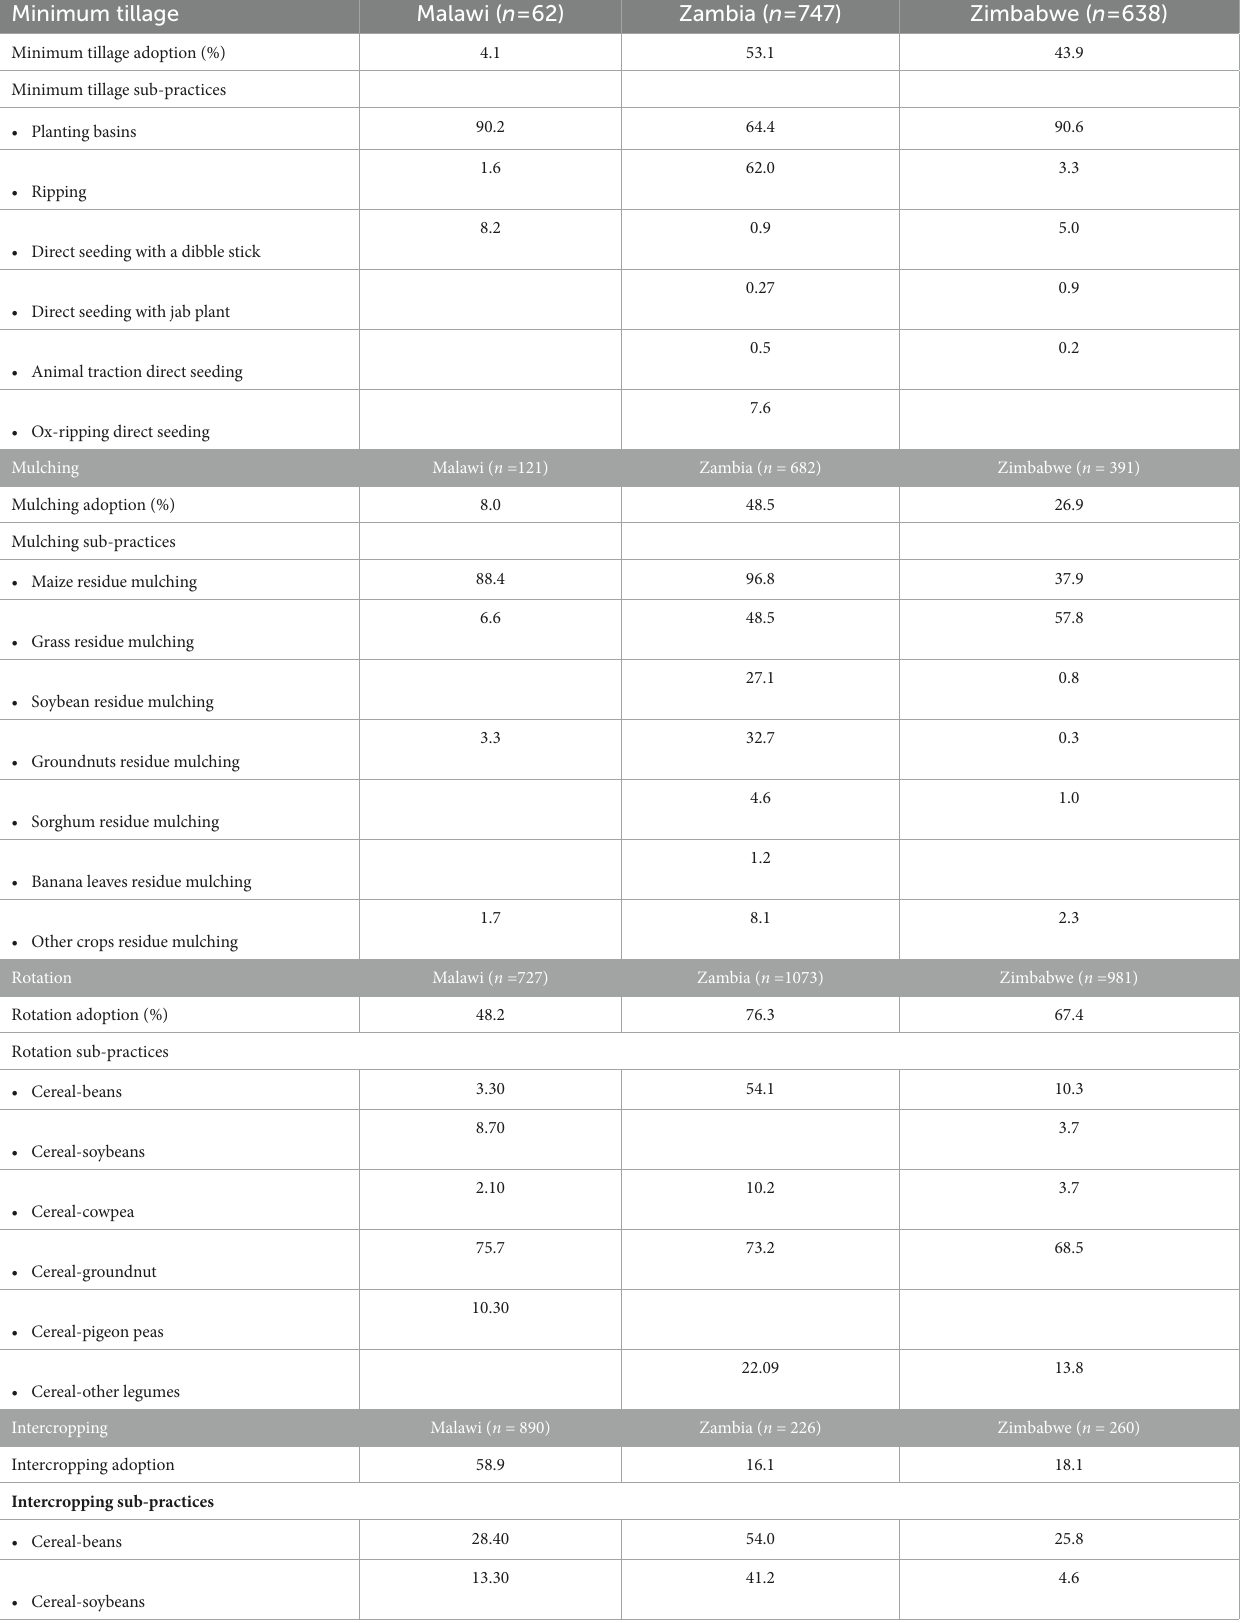
TABLE 9 Adoption of CA practices by country (multiple responses within a component in % of households). Minimum tillage Malawi ( n = 62) Zambia ( n = 747) Zimbabwe ( n =